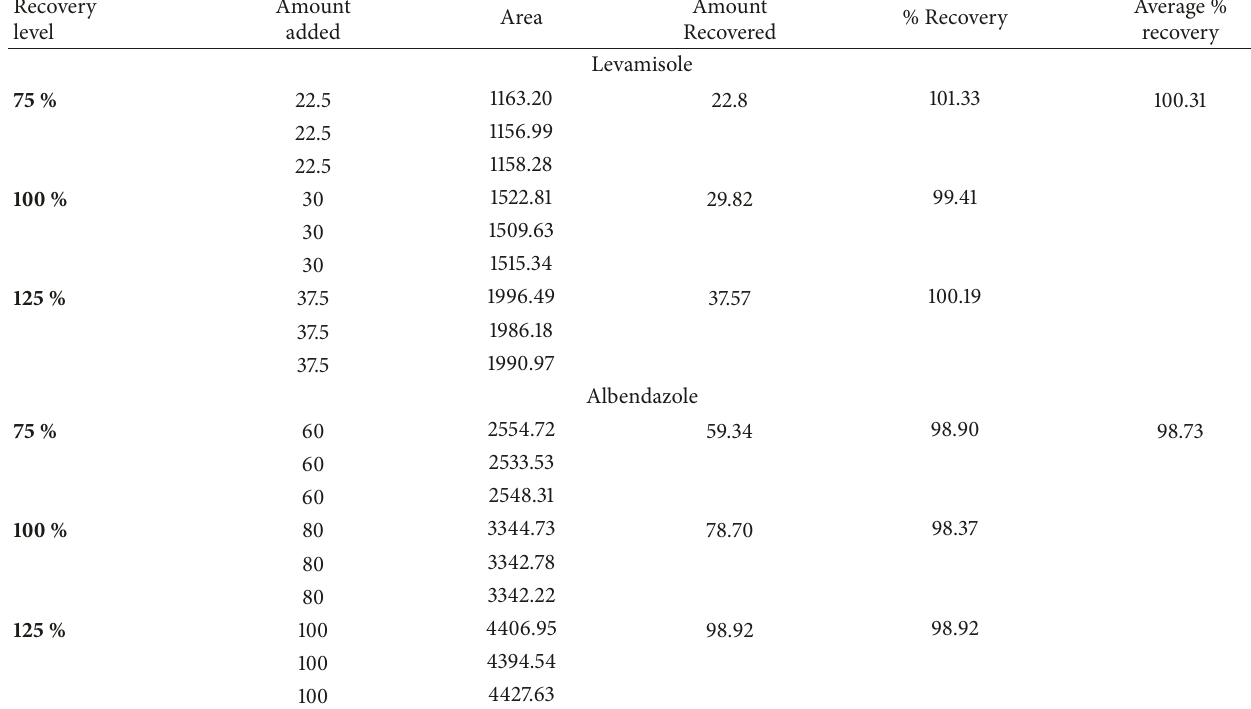
Table 3: Results of accuracy by recovery studies.